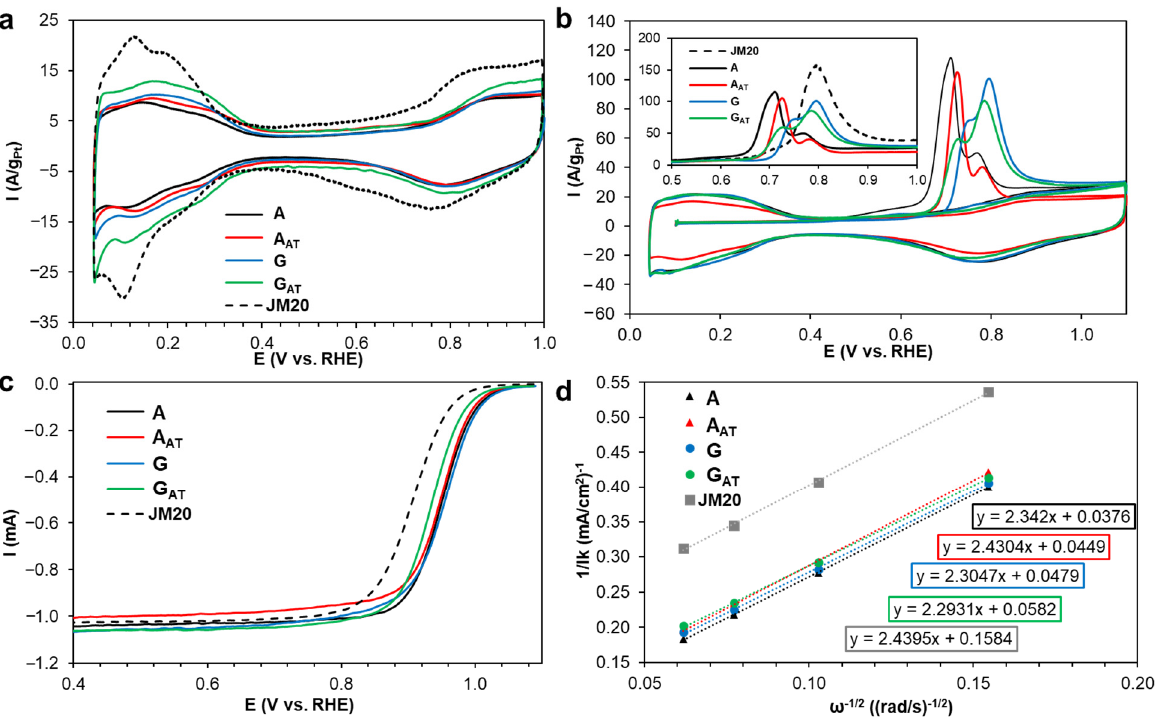
Figure 4. The cyclic voltammograms, the potential sweep rate is 20 mV s − 1 ( a ), CO stripping, the potential sweep rate is 40 mV s − 1 ( b ) of the samples activated in the potential range of 0.04–1.00 V, under the Ar atmosphere. The linear voltammograms of the oxygen electroreduction in the studied catalysts at the disk rotation speed of 1600 rpm, the potential sweep rate is 20 mV s − 1 , under the O 2 atmosphere ( c ). 0.1 M HClO 4 . The dependence 1/j of ω − 1/2 at the potential of 0.90 V ( d ).